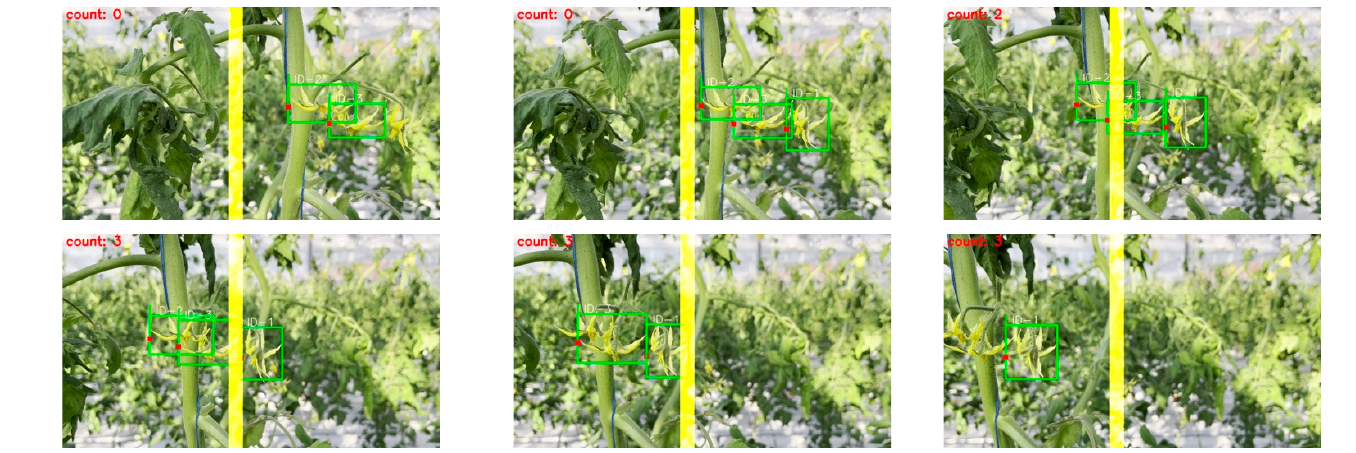
Figure 16. Counting the number of tomato flowers in the greenhouse.